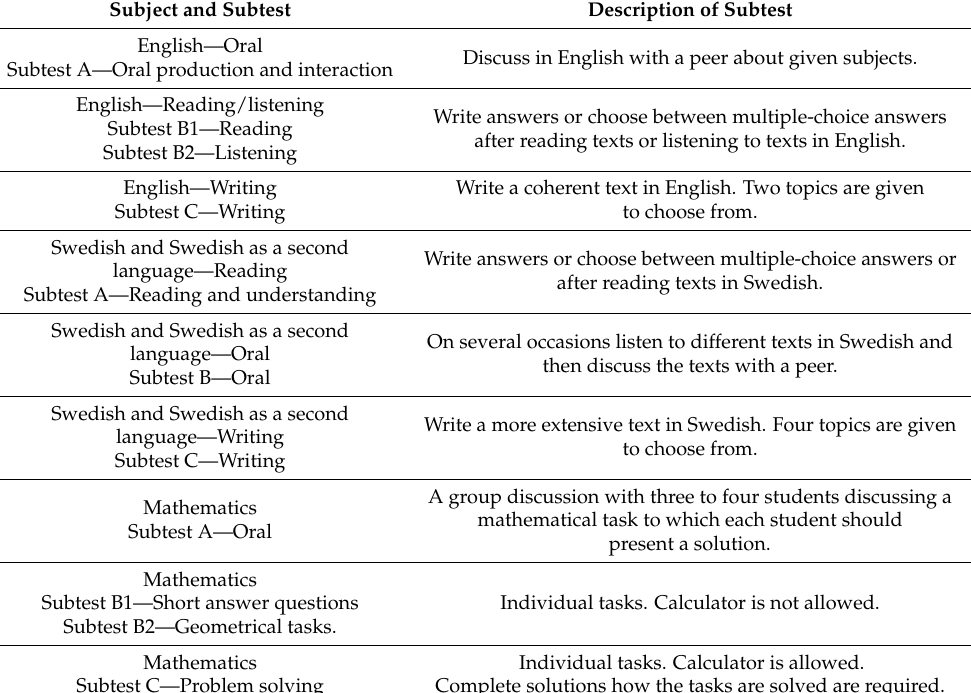
Table 2. Contents of the different subtests in the national tests of the subjects English, Swedish and